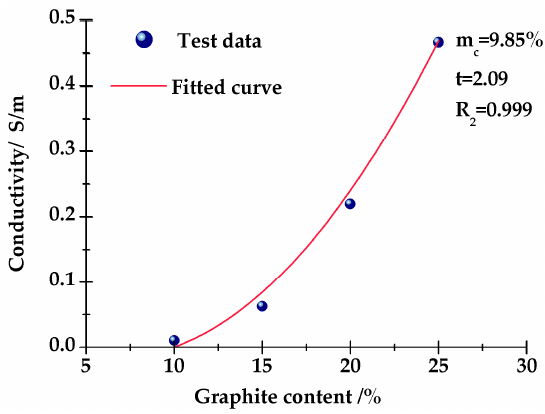
Figure 11. Percolation test data and best-fitting curve.